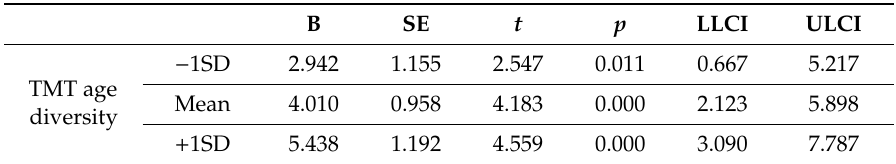
Table 3. Conditional e ff ect of age diversity.